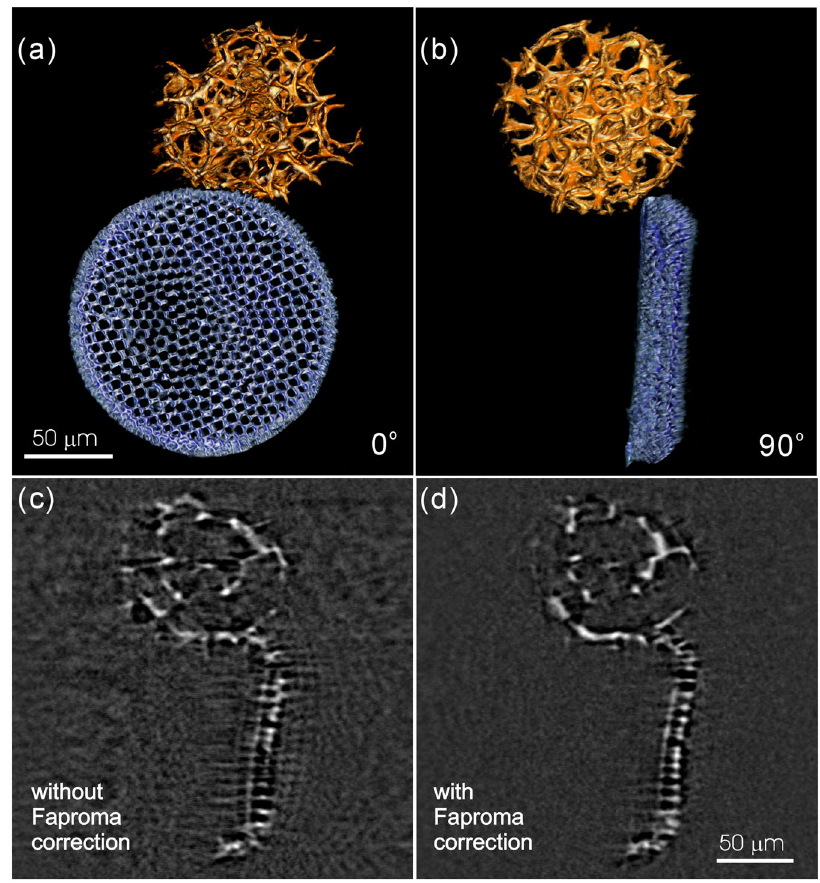
Figure 7. Synchrotron X-ray micro-CT data corrected using Faproma. ( a,b ) Well corrected 3D tomography of micro-fossils at 0° and 90°. ( c ) Reconstructed section without applying any registration